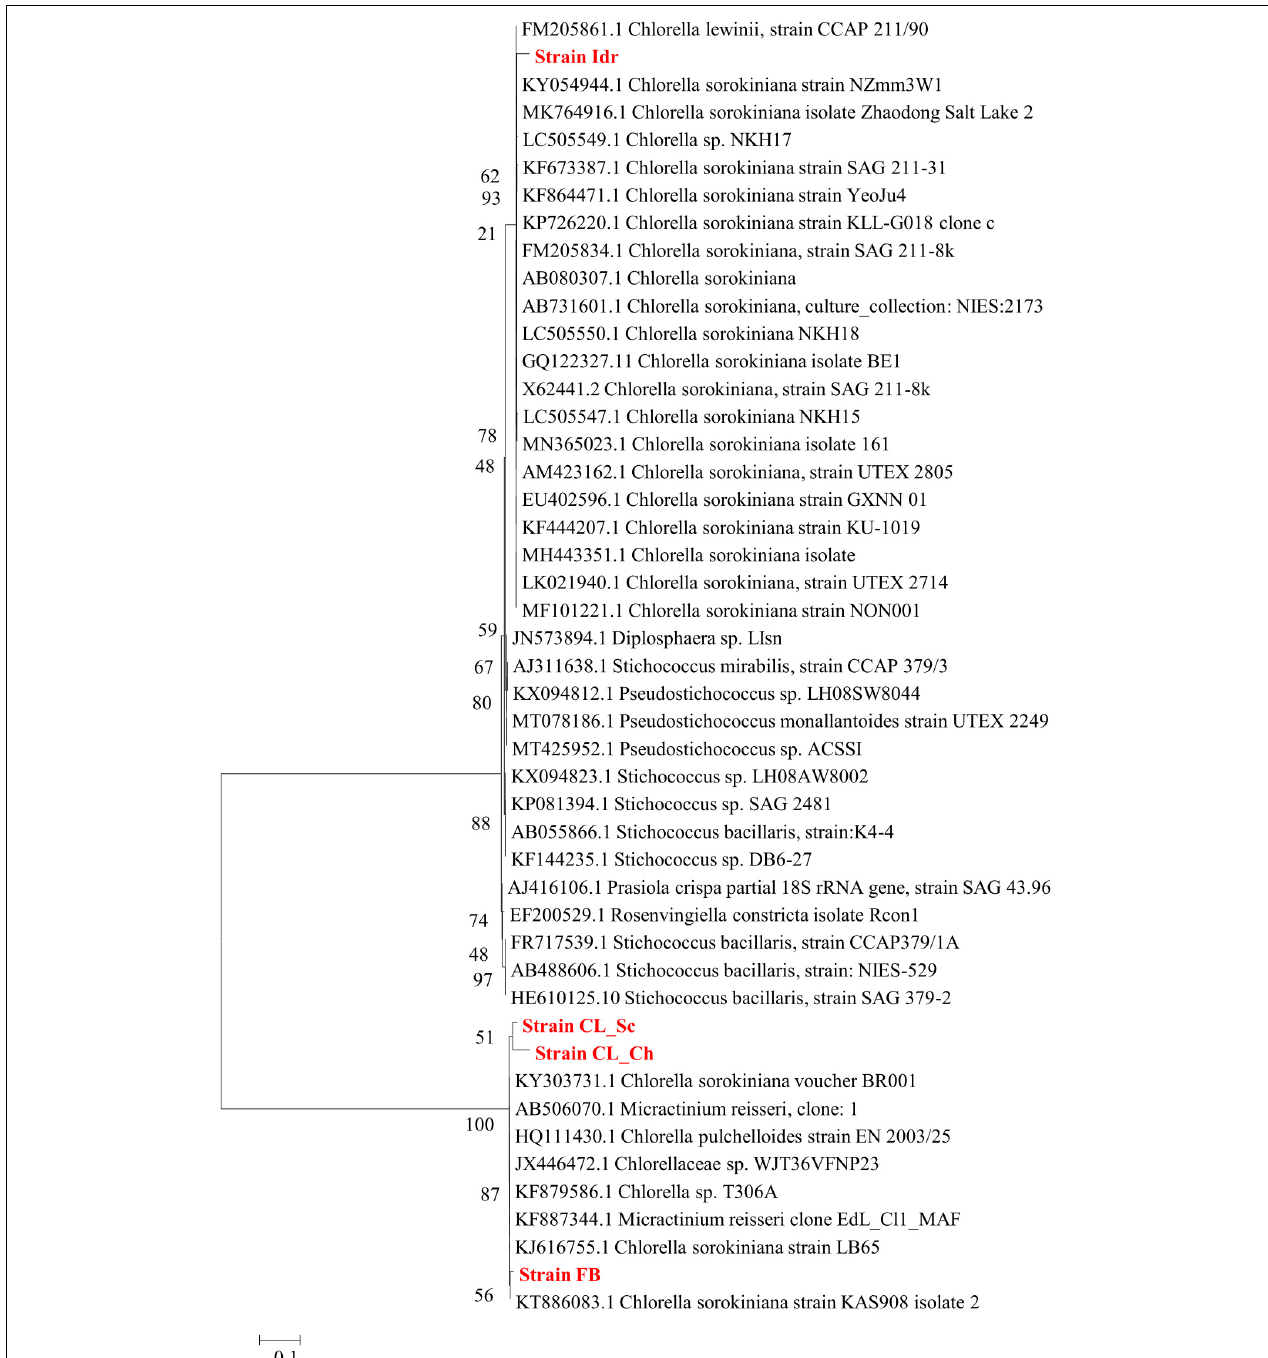
FIGURE 3 | Phylogenetic tree reconstruction obtained with Maximum Likelihood method on a total of 43 high quality sequences selected from the most similar to the sequences obtained for the four strains analyzed in this work (Acc. N. MT992788-MT992791). Reconstruction was performed with 500 bootstrap resampling and the following parameters: Model/Method = General Time Reversible model; Rates among sites = Gamma distributed with invariant sites (G + I); Gaps = Use all sites; ML heuristic method = Nearest neighbor Interchange (NNI); Branch swap filter = Strong.